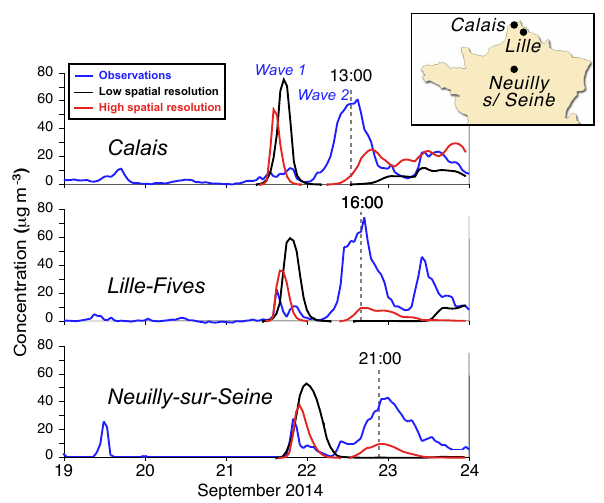
Figure 12. SO 2 ground-level concentration observed by air qual- ity networks in France (blue) and modelled with high (red) or low (black) horizontal resolution simulations, both configured with the YSU PBL parameterization